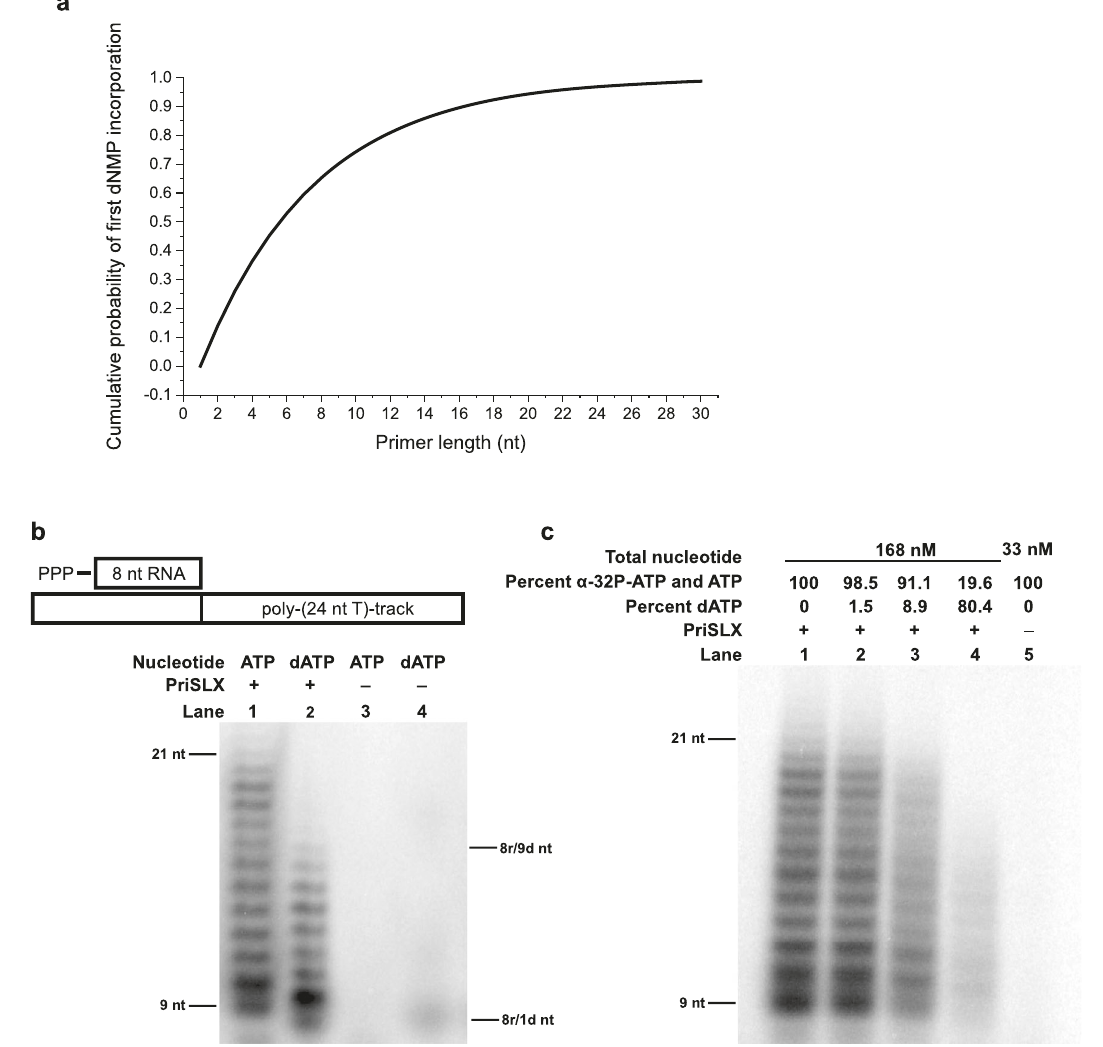
Fig. 6 Impact of dNMP incorporation on primer synthesis. a Geometric probability model of dNMP incorporation by PriSLX as a function of primer length. Model assumes NTP as the initiating nucleotide and that nucleotide incorporation proceeding from RNA-primer is governed exclusively by equal weighting of relative dNTP/NTP abundance and elongation-site binding af fi nity. b Top panel: representation of the 5 ′ -triphosphate 8 nt RNA-primer annealed to the poly-(24 nt T)-track. Bottom panel: primer elongation reactions of ATP (2 µ Ci/20 ul α - 32 P-ATP and 165 nM ATP) or dATP (2 µ Ci/20 ul α - 32 P-dATP and 165 nM dATP) as indicated; 15 nM 5 ′ -triphosphate 8 nt RNA-primer annealed to poly-(24 nt T)-track template; and 3.75 nM PriSLX as indicated. Reactions were incubated for 2 min at 75 °C prior to termination and electrophoresis on denaturing polyacrylamide gels. Four independent replicates of this experiment were performed. c Primer elongation reactions of 2 µ Ci/20 ul α - 32 P-ATP with unlabeled ATP and dATP as indicated for total nucleotide concentration as indicated; 15 nM 5 ′ -triphosphate 8 nt RNA-primer annealed to poly-(24 nt T)-track template; and 3.75 nM PriSLX as indicated. Reactions were incubated for 2 min at 75 °C prior to termination and electrophoresis on denaturing polyacrylamide gels. Three independent replicates of this experiment were